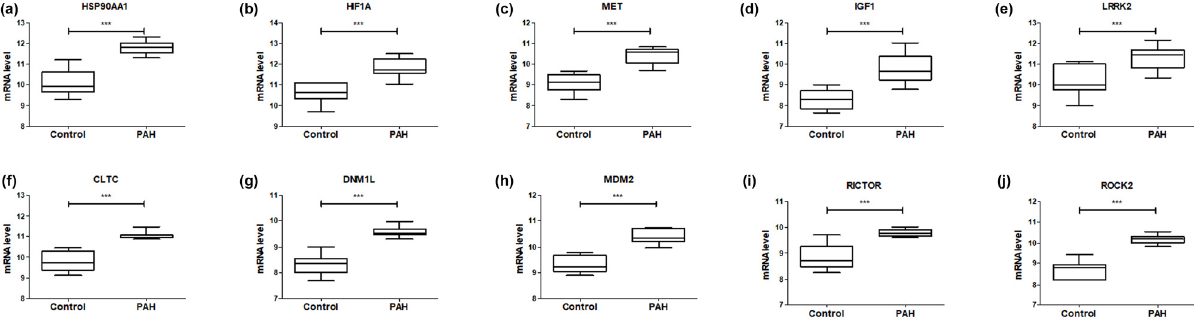
Figure 6: Veri fi cation expression levels of hub genes in GSE53408 dataset: ( a ) HSP90AA1, ( b ) HIF1A, ( c ) MET, ( d ) IGF1, ( e ) LRRK2, ( f ) CLTC, ( g ) DNM1L, ( h ) MDM2, ( i ) RICTOR, and ( j ) ROCK2. GSE53408 contains 11 healthy individuals and 12 severe pulmonary arterial hypertension patients. *** P < 0.001.